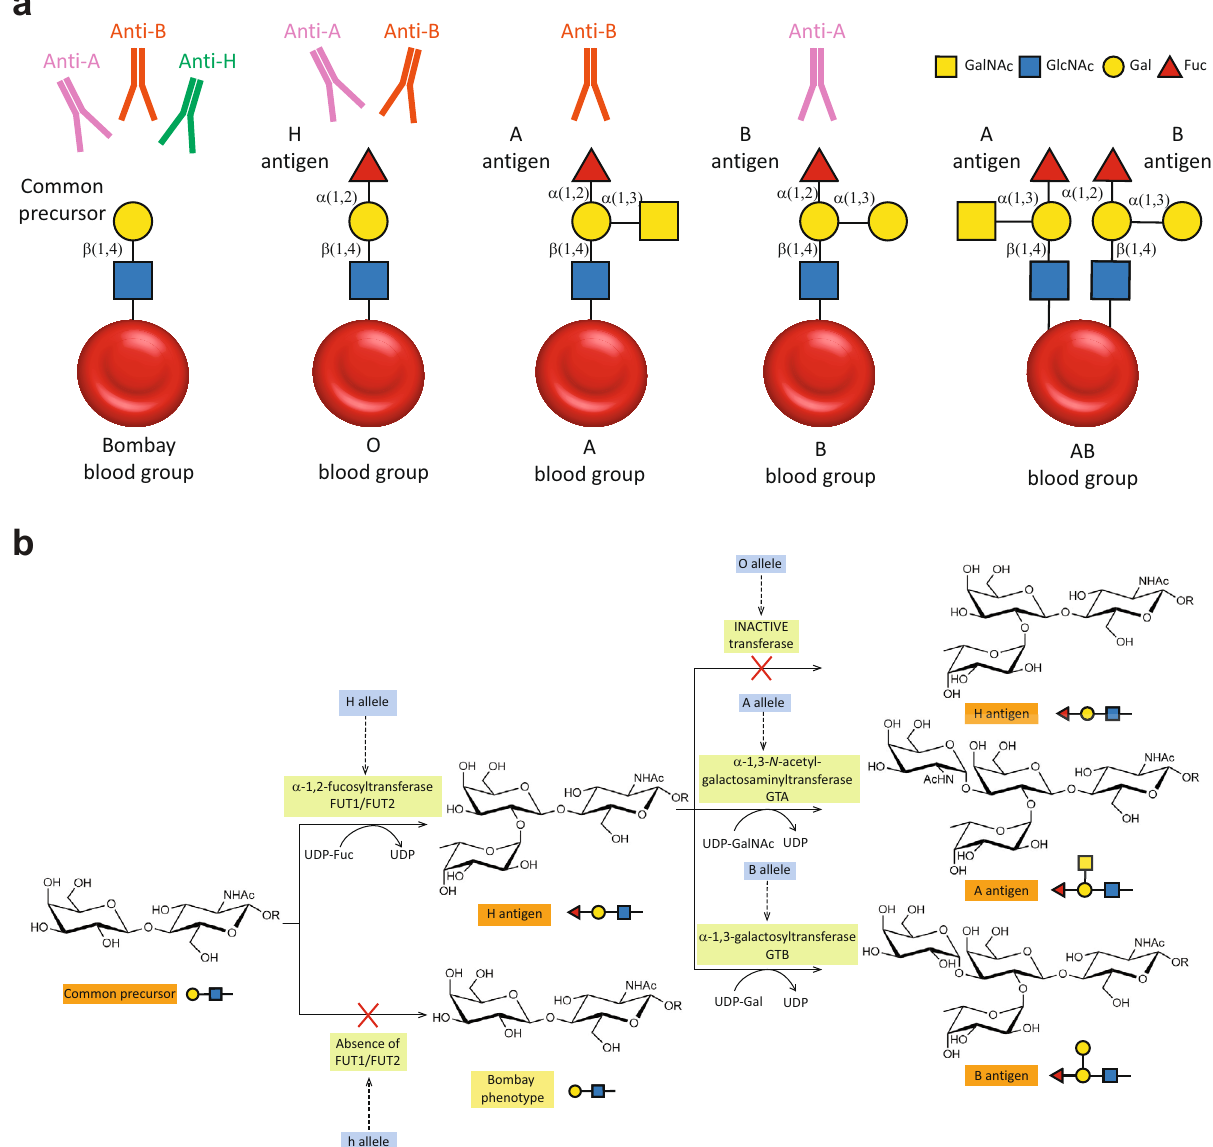
Fig. 1 | A, B, H, and Bombay antigens in RBCs. a Cartoon representation of Bombay, O, A, B, and AB blood groups antigen ’ s carbohydrate epitopes present in RBCsurface(RBCaredepictedasredcircles)andantibodies. b Enzymaticpathway